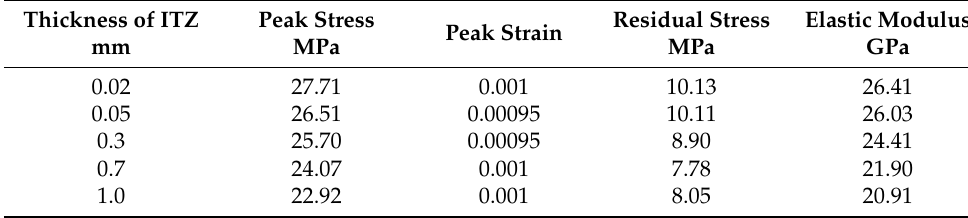
Figure 16. The effect of the thickness of ITZ on the stress–strain curve of RAC under uniaxial compression. ( a ) Stress–strain curve; ( b ) linear fitting of the elastic modulus; ( c ) linear fitting of the peak compressive strength. Table 6. The statistics of peak stress and peak strain of RAC with different ITZ